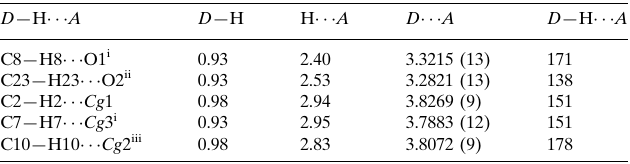
Hydrogen-bond geometry (A˚ , (cid:1) ). Cg 1, Cg 2 and Cg 3 are the centroids of the C4–C9, C12–C17 and C19–C24 rings,